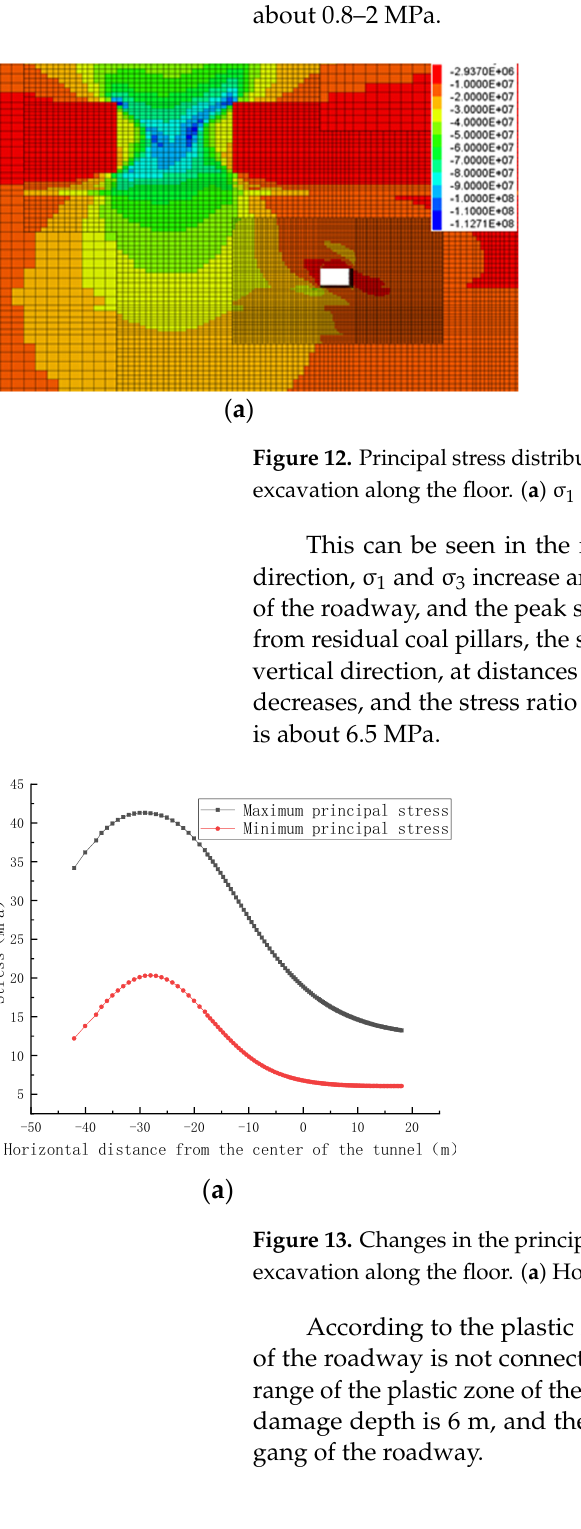
Figure 14. Plastic zone distribution cloud map when the roadway excavation along the floor. 3.1.2. Roadways with Horizontal Layer Differences (1) The coal column is 4 m When the coal pillar is 4 m, the horizontal distance between the roadway and the residual coal pillar is 31.85 m, and the vertical distance is about 18.5 m. According to the stress cloud diagram (Figure 15), σ 1 and σ 3 appear at the residual coal column of the over- lying coal seam, and σ 1 near the residual coal column is about 60 – 115 MPa. σ 3 is about 22 – 60 MPa. σ 1 around the roadway is about 5 – 18 MPa, and σ 3 is about 0.4 – 1 MPa.